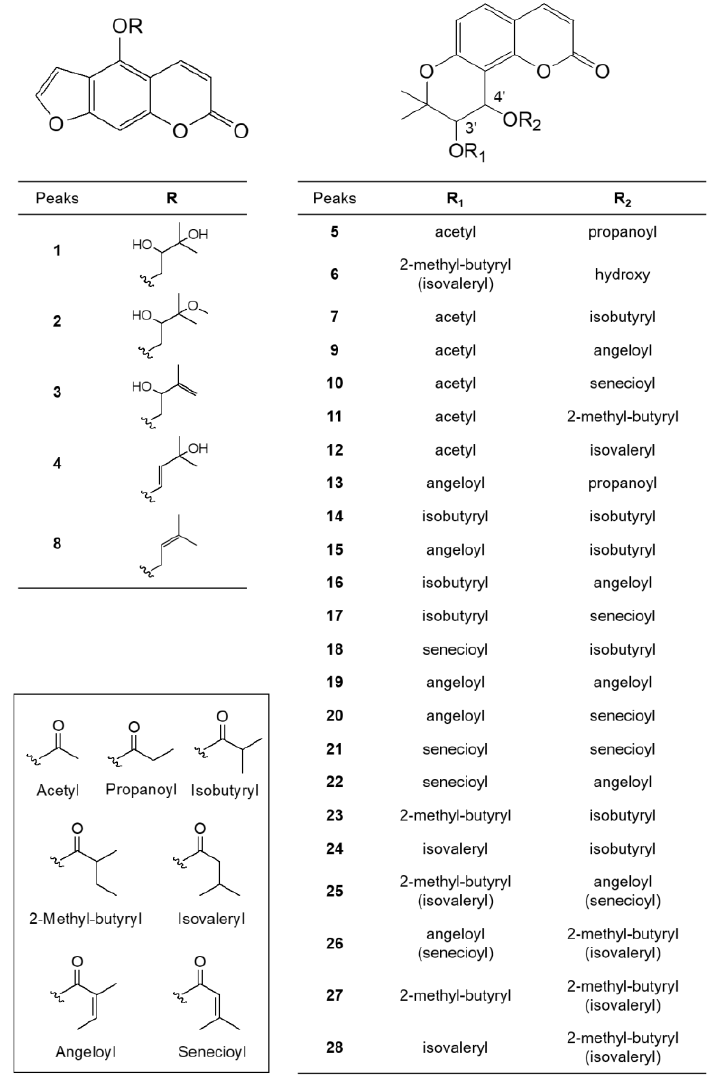
Figure 2. Structures of identified coumarins (Peaks 1 –